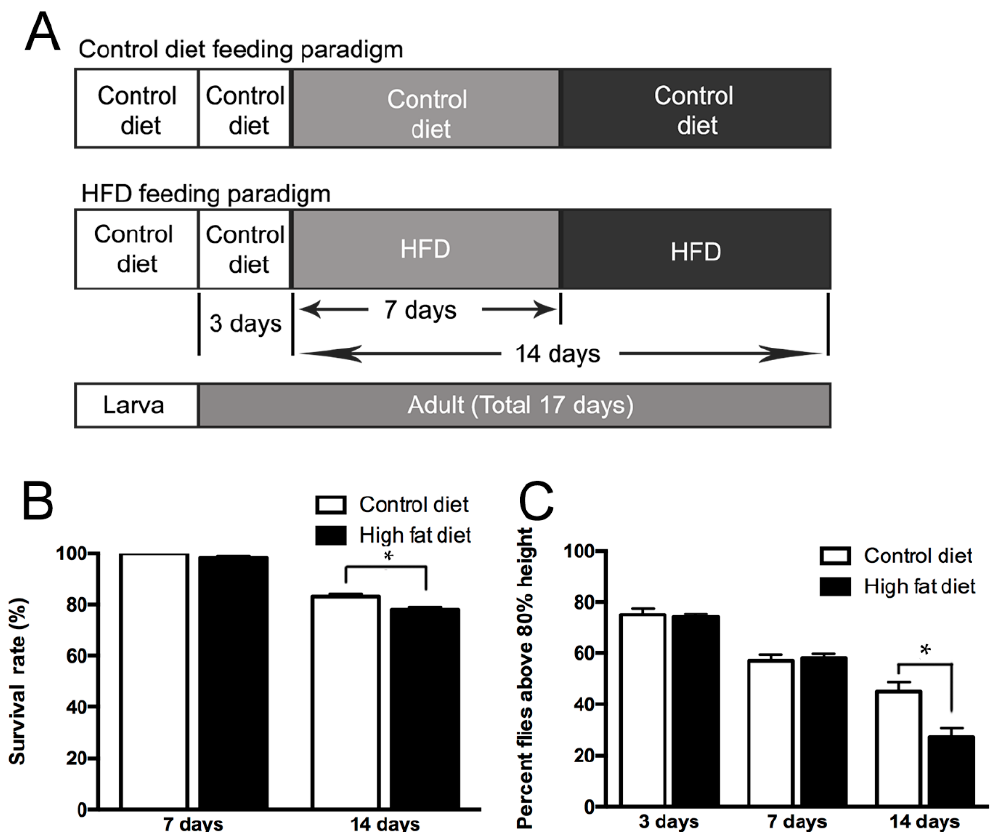
Figure 1. Physiological effects of high-fat diet (HFD) intake on wild type Canton-S flies. ( A ) Food treatment condition and feeding paradigm. The control diet and HFD were treated ad lib for seven and 14 days in male Canton-S flies. ( B ) Lifespan of wild flies fed with control diet and HFD. ( n = 5, * p < 0.05). Error bars represent SEM. ( C ) Locomotor activity of wild type Canton-S flies fed with control diet and HFD. ( n = 10, * p < 0.05). Error bars represent SEM.